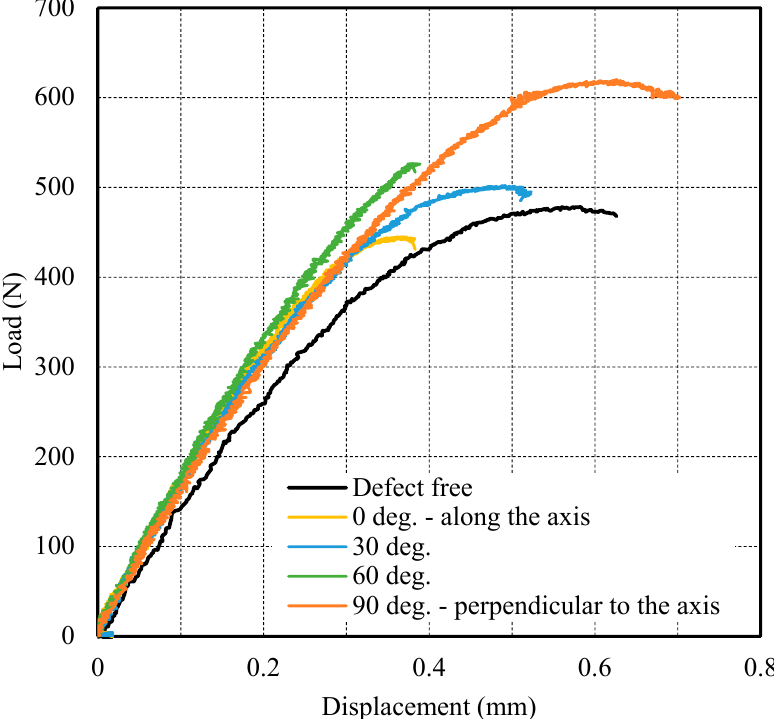
Figure 15. Load-displacement curves of white samples set with a defect at different orientations.